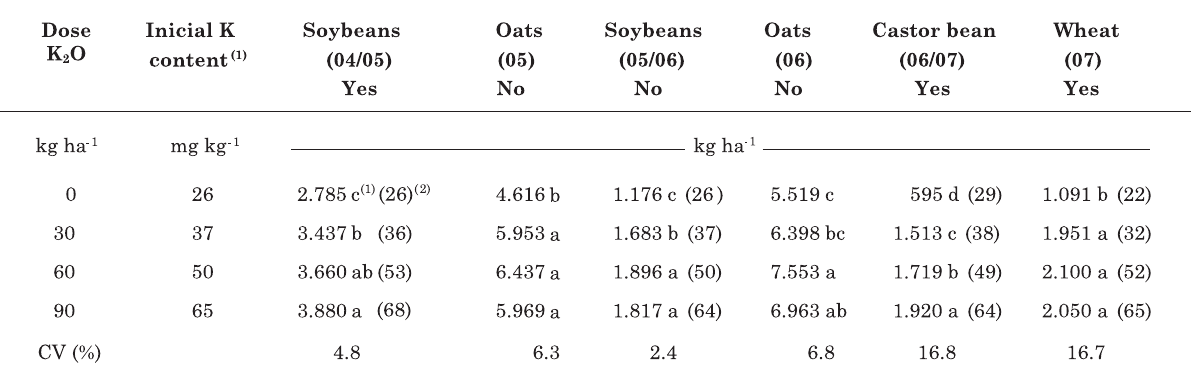
Table 2. Grain yield of commercial crops and dry matter of cover crops arising from the potassium application on the soil